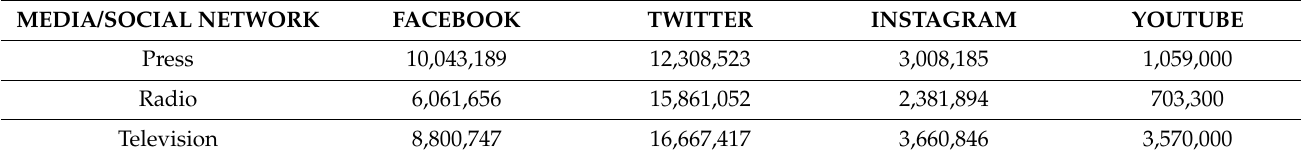
Table 1. Media and its users (31 May 2020).